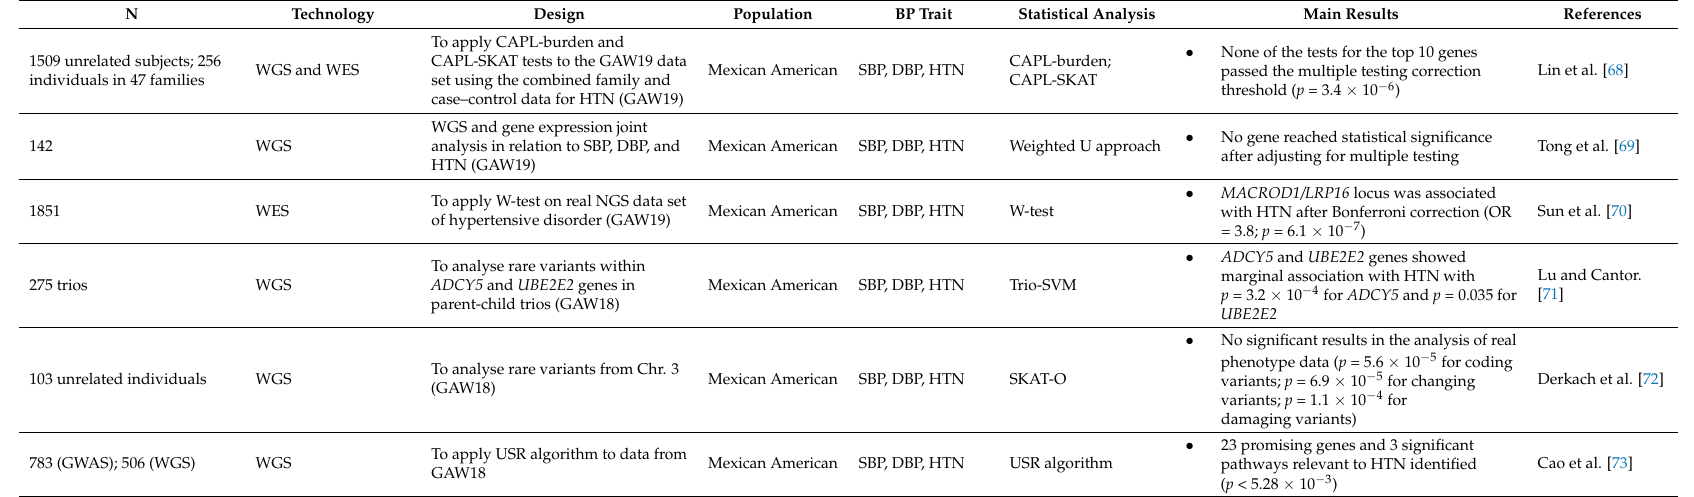
Table 3. Results from Next-Generation Sequencing